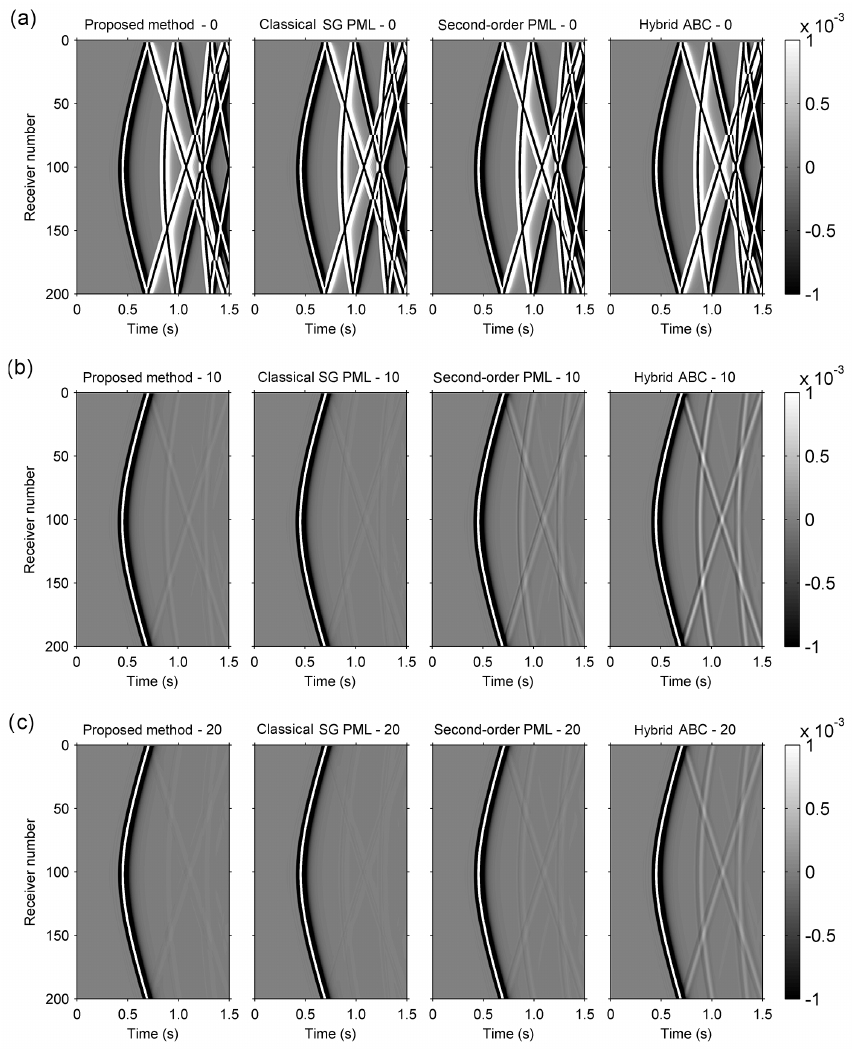
Figure 12. Receiver records of the four methods for a different number of absorbing layers: (a) 0 absorbing layers, (b) 10 absorbing layers, and (c) 20 absorbing